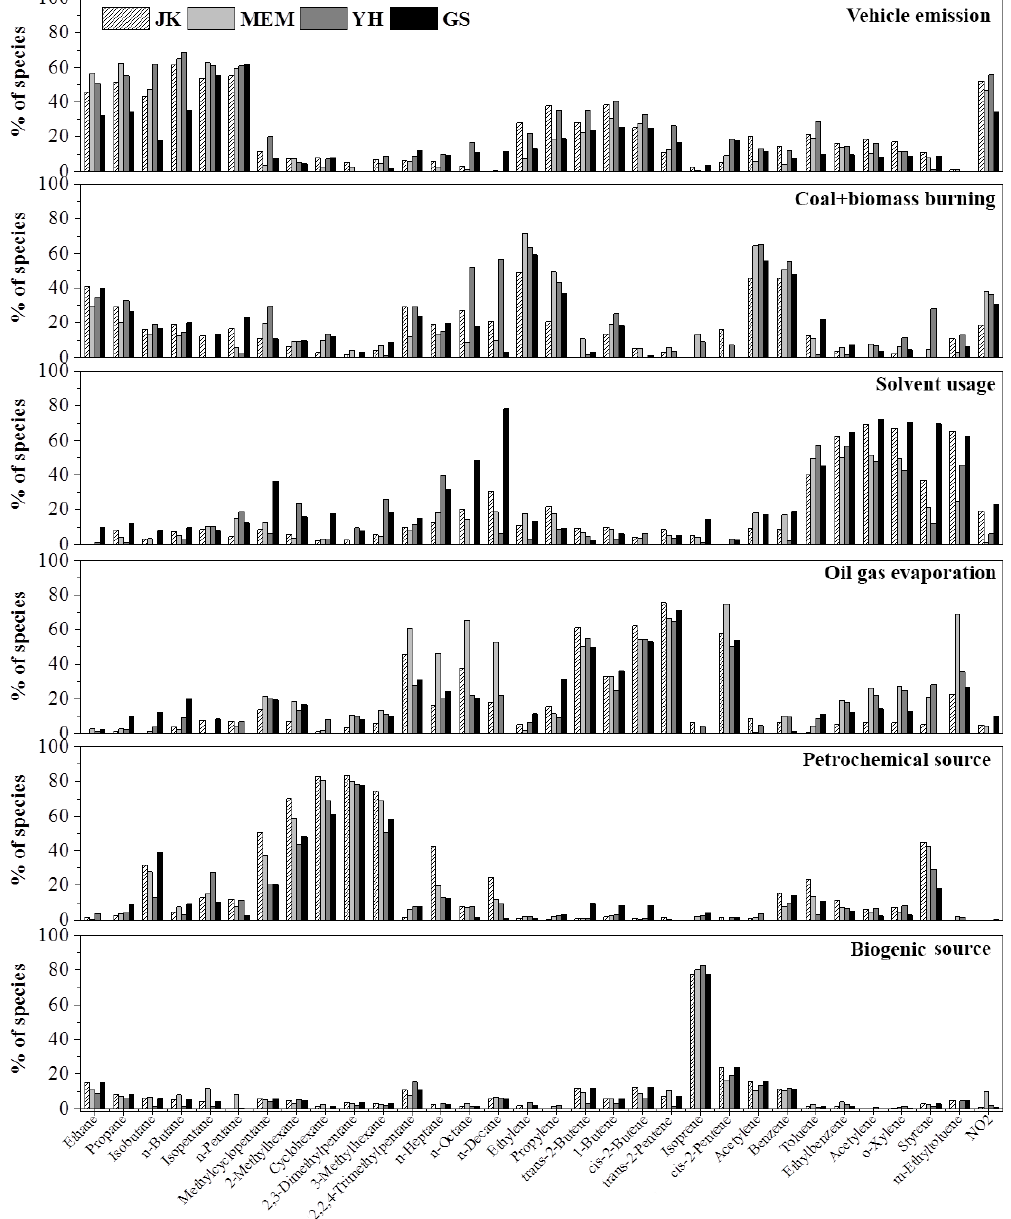
Figure 15. Factor profiles of major emission sources, namely vehicle emissions, coal + biomass burning, solvent usage, oil gas evaporation, petrochemical source and biogenic source resolved by positive matrix factorization (PMF)